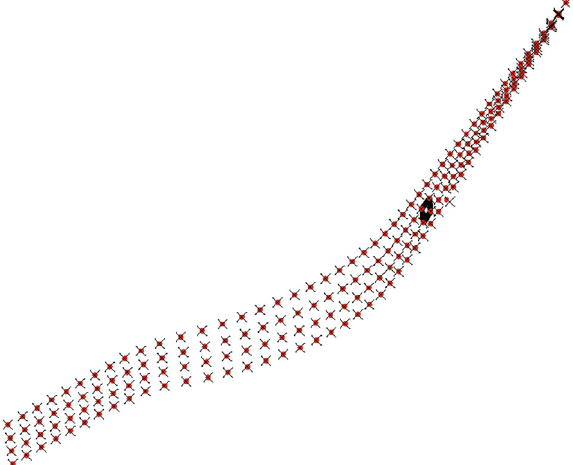
Figure 11: Needle eroded pro fi le (red dots) and uneroded pro fi le (black